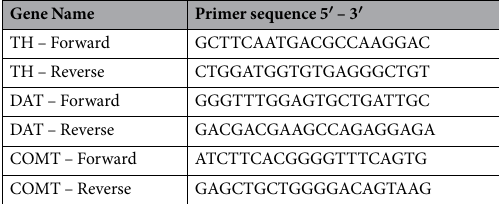
Table 1. Primer Sequences used for real-time